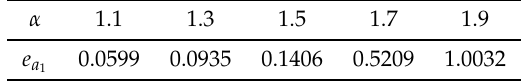
Figure 1. The absolute error between analytic solution a ( x ) and the regularized solution a δ α = 1.2 and various ε for Instance